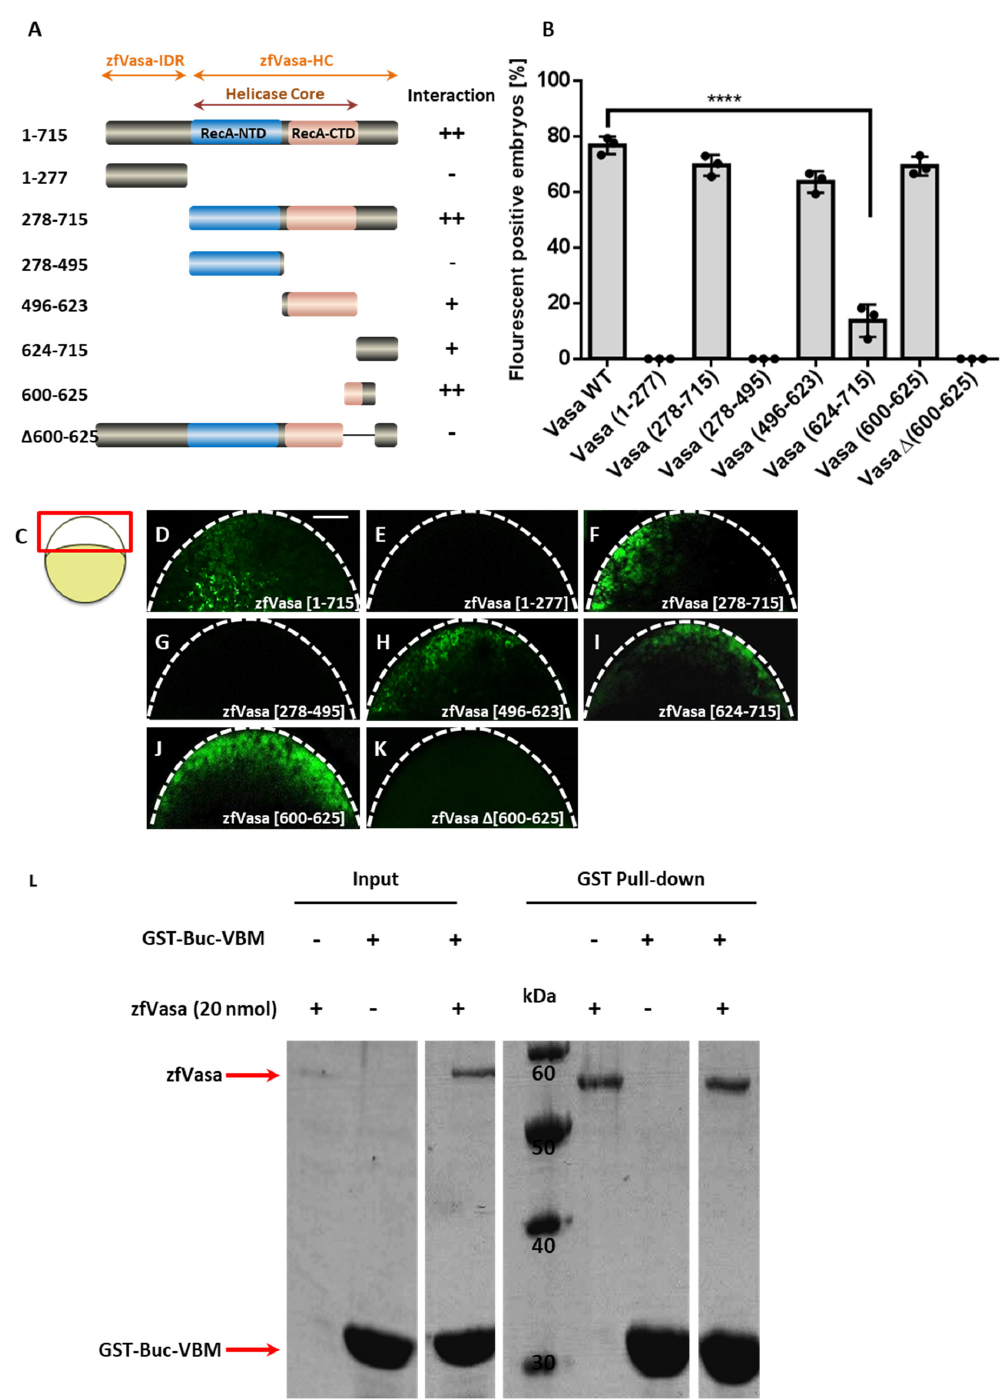
Figure 2. Mapping the Buc-binding motif in zfVasa (zfVasa-BBM). ( A ) Schematic illustration of the systematic truncation of zfVasa (dark grey) with a helicase core containing the N-terminal (blue) and C-terminal (light rose) RecA-like domains. Numbers left to the colored bars indicate the corresponding amino acids. ( B ) Quantification of fluorescent-positive embryos based on the microinjection of mRNA encoding the different combinations of BiFC Buc and zfVasa constructs. The data presented are averaged from three independent experiments. The Y-axis represents the percentage of fluorescent embryos, and the X-axis shows the injected constructs. Error bars represent the standard deviation of the mean. Average fluorescent-positive embryos ≥ 60% denoted as ‘++’, average fluorescent-positive embryos ≤ 60% shown as ‘+’, and embryos with no fluoresce denoted as ‘-‘. ( D – K ) Confocal images of live embryos at 3 hpf (hours post-fertilization) after